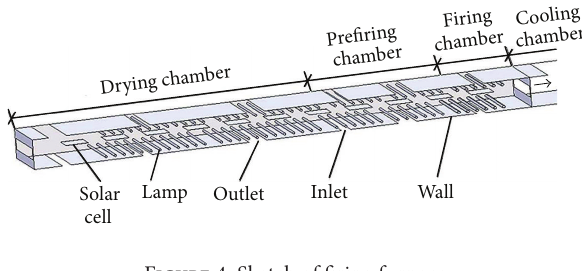
Figure 4: Sketch of firing